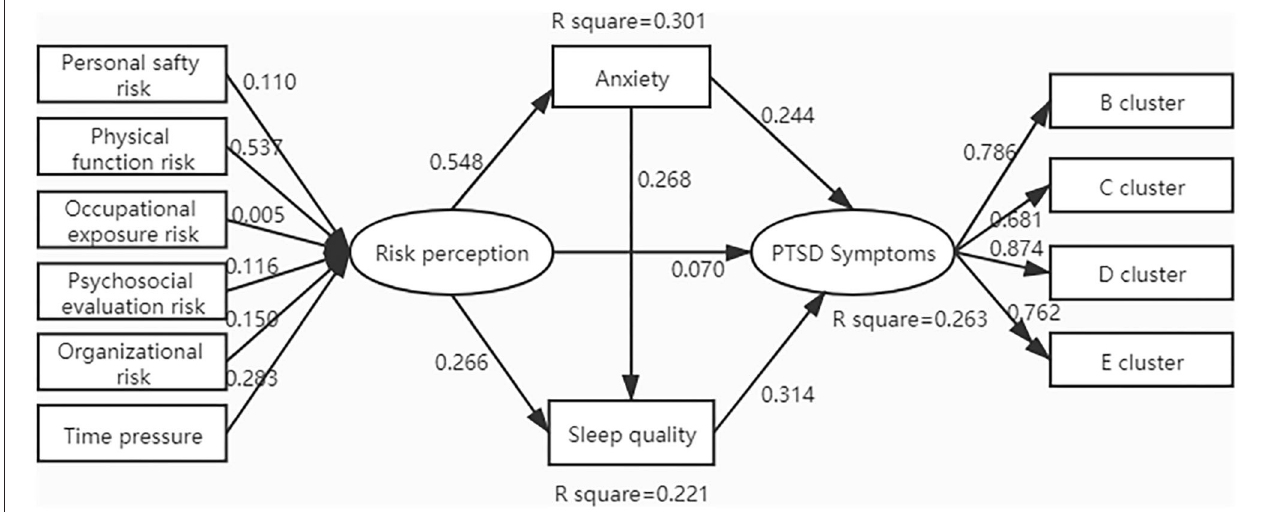
FIGURE 1 | The chain-mediating effect of anxiety and sleep quality on the relationship between risk perceptions and PTSD symptoms using a PLS model.